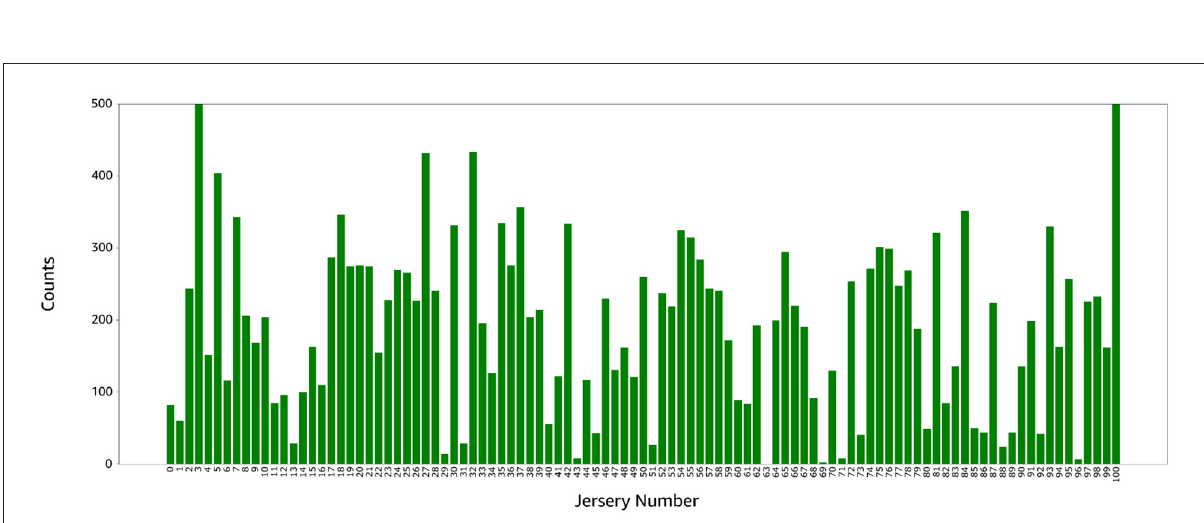
FIGURE5 Distribution of the jersey number labels in the training set. Number 3 has 500+ images while numbers 43, 63, 69, and 93 have 10 images or